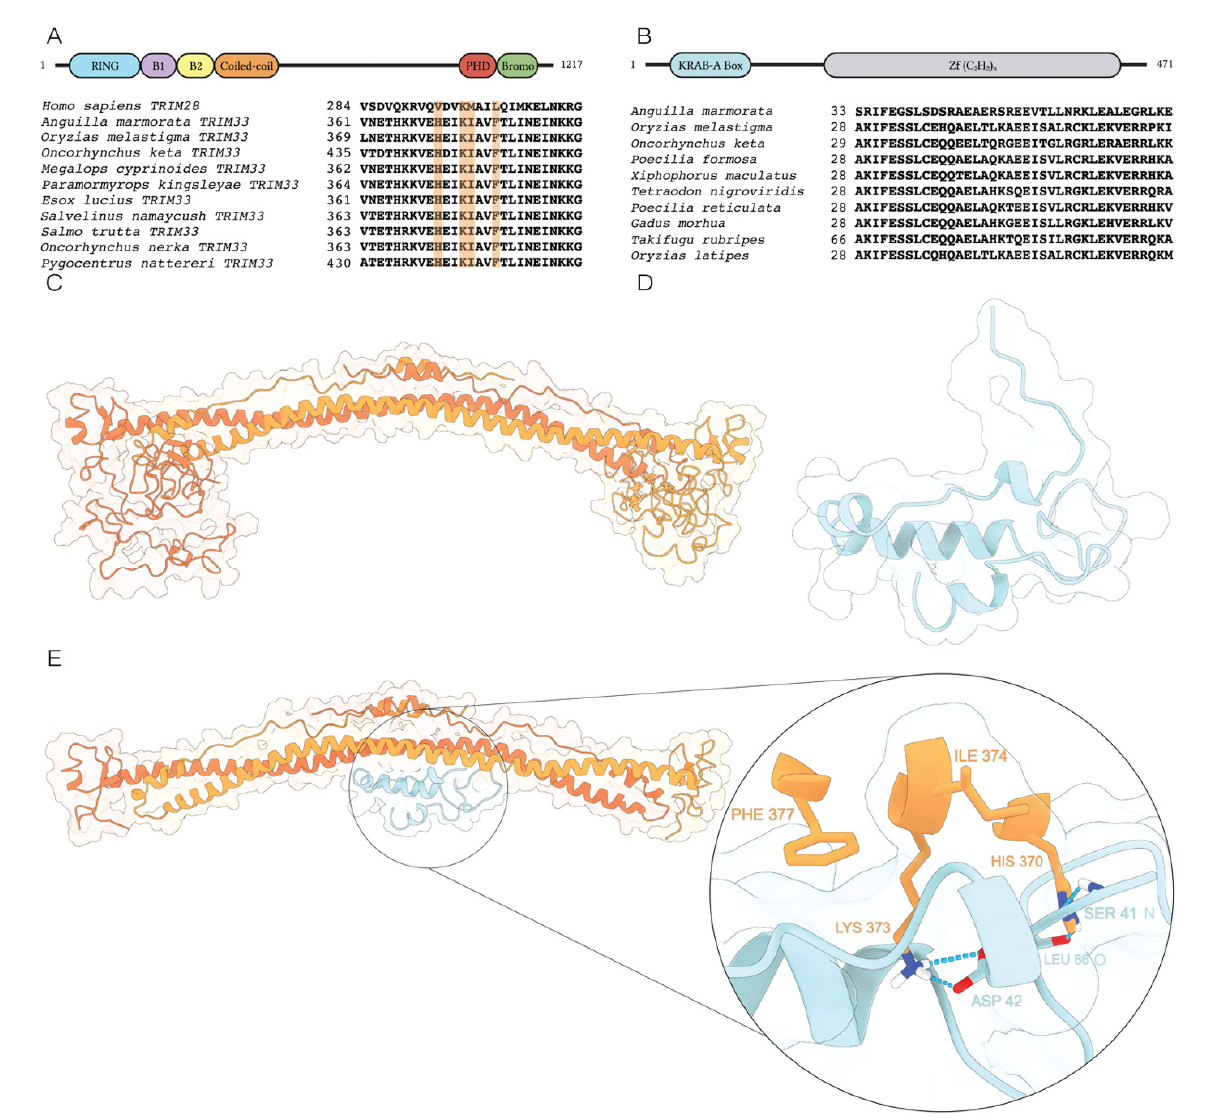
Figure 5. Multiple sequence alignment and 3D structures of the KRAB domain contained in the KRAB-like protein and that of TRIM33 protein. ( A ) In the upper side, a schematic representation of the domain architecture is reported for the A. marmorata TRIM33 protein. In the lower side, multiple sequence alignment related to the coiled-coil region of Homo sapiens TRIM28 protein and of ten actinopterygian TRIM33 sequences is showed. The main interacting residues at the interface are highlighted in orange. ( B ) In the upper side, a schematic representation of the domain architecture is reported for the Anguilla marmorata KRAB-like protein. In the lower side, the N-terminal region multiple sequence alignment of ten actinopterygian KRAB-like sequences is reported. ( C ) Ribbon and surface representation of A. marmorata TRIM33 structural model. Chain A and chain B are colored in dark and light orange, respectively. ( D ) Ribbon and surface representation of the putative A. marmorata KRAB-like domain. ( E ) Ribbon and surface representation of docked TRIM33/KRAB-like complex with a zoom on the residues H370/K373/I374/F377.